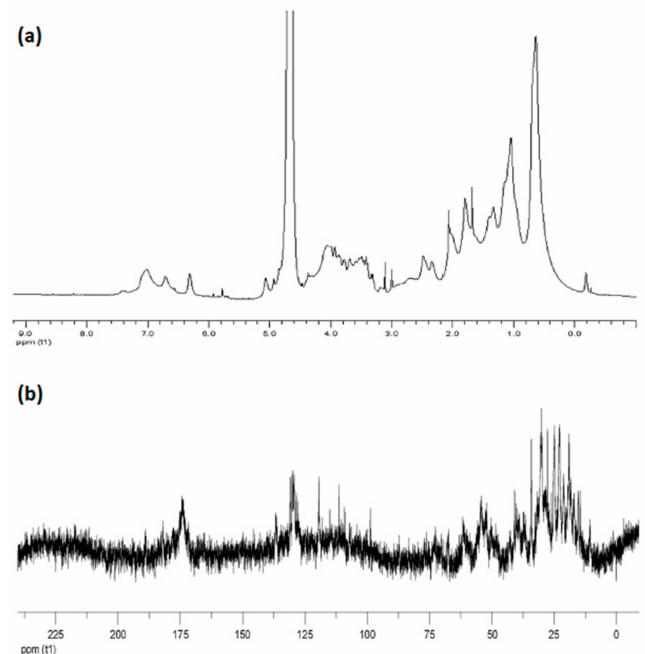
Figure 8. ( a ) The 1 H-NMR spectrum and ( b ) the 13 C-NMR spectrum of melanin extracted from Lachnum